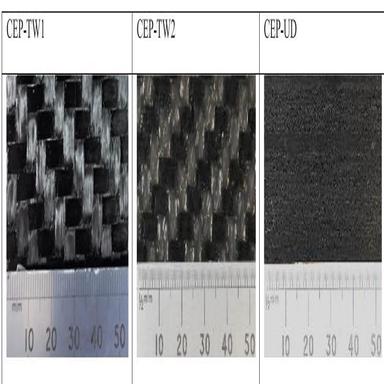
The images of three types of prepregs investigated for their intraply shear formability characteristics.